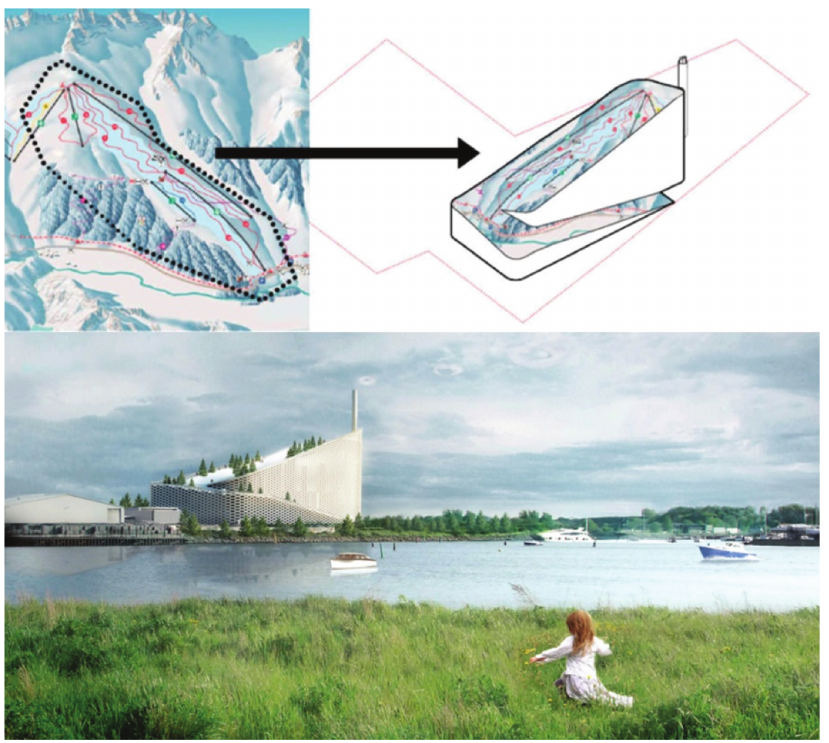
Figure 6. Unapologetic biomimicry: BIG’s Amager Bakke Waste-to-Energy Plant in Copenhagen © BIG-Bjarke Ingels